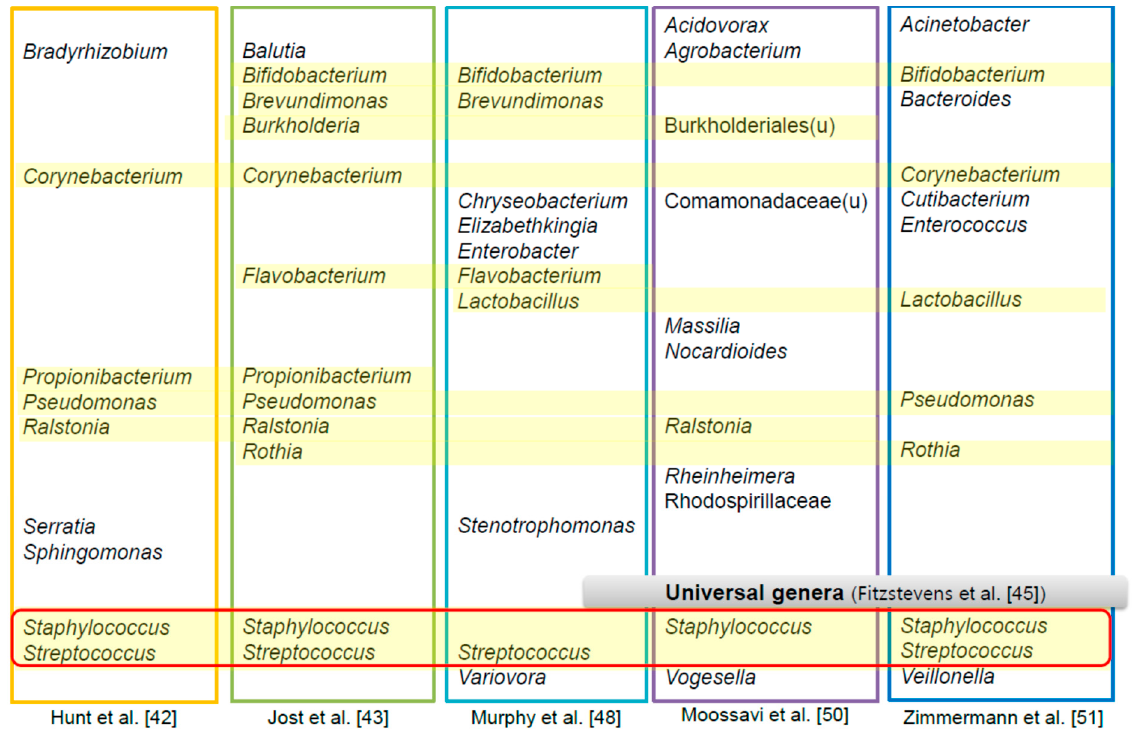
Figure 2. Core genera of human breast milk microbiome in several studies [42,43,45,48,50,51].